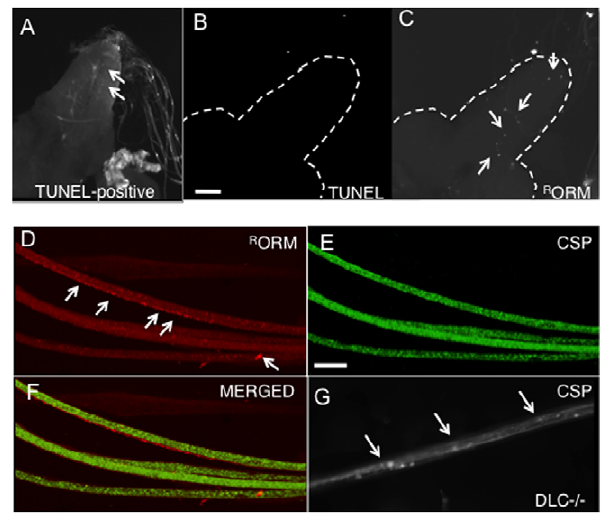
Figure 7. ORMOSIL incorporation does not activate aberrant neuronal cell death pathways or affect the axonal transport pathway. (A, B, C) ORMOSIL nanoparticle incorporation does not induce aberrant neuronal cell death pathways in the cell bodies of the larval brain. A control brain incubated with DNAse and treated with the TUNEL assay shows TUNEL positive cells (A, arrows). A representative fluorescence image from a larval brain (outlined) incubated with R ORM was assayed for neuronal cell death using the TUNEL assay. Using the 488 nm filter, no fluorescence was observed in the larval brain indicating that there were no nuclei showing neuronal cell death (B) in contrast to A. However, R ORM was present within the larval brain (using the 568 nm filter, arrows). Note that ORMOSIL is seen as puncta (C). Images were taken using the 40 6 objective. Bar=20 m m. (D, E, F, G) ORMOSIL incorporation does not affect the axonal transport pathway. A representative image of larval segmental nerves from a dissected R ORM treated larvae does not show axonal blockages using the synaptic vesicle antibody, CSP ( E ). Note that ORMOSIL aggregates can be seen in these larval segmental nerves (arrows, D ). F shows the merged image. In contrast, larval segmental nerves from an axonal transport mutant (dynein mutant, DLC) show axonal blockages (arrows, G ). Images were taken using the 40 6 objective. Bar=20 m m. brains expressing SYNT-GFP treated with ORMOSIL (unconju- gated and conjugated, data not shown). Thus our observations indicate that ORMOSIL incorporation at the concentrations we used does not interfere with the movement of synaptic vesicles in vivo , an essential pathway for neuronal integrity and survival.